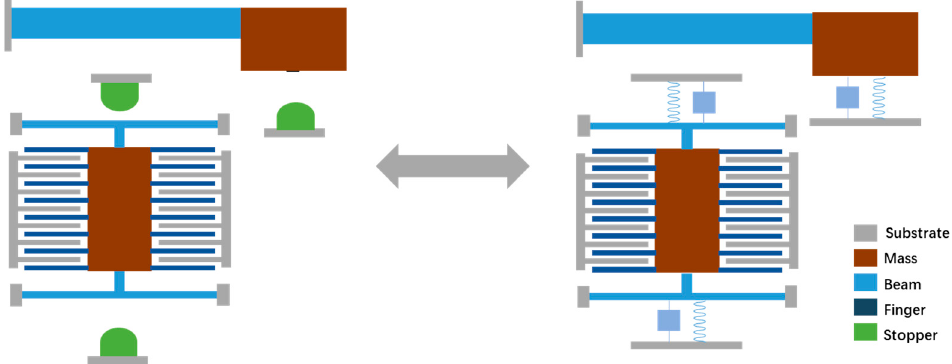
Figure 7. The diagram and spring-damping model of the MEMS stopper